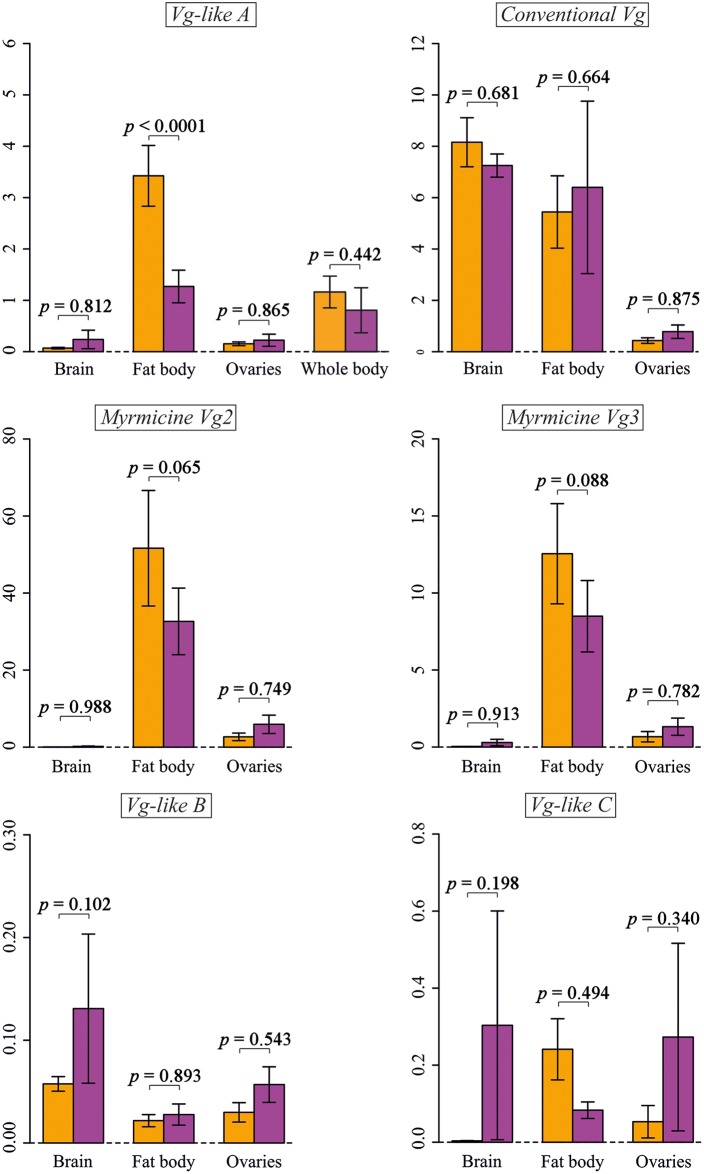
Tissue-specific expression of Temnothorax Vg and Vg-like genes.mRNA of each gene was quantified via qPCR relative to alpha tubulin expression. A knockdown of Vg-like A (purple bars) reduced Vg-like A expression in the fat body. The expression of no other Vg or Vg-like gene was altered by a Vg-like A knockdown. Orange bars: control. qPCR, quantitative real-time PCR; Vg, vitellogenin.